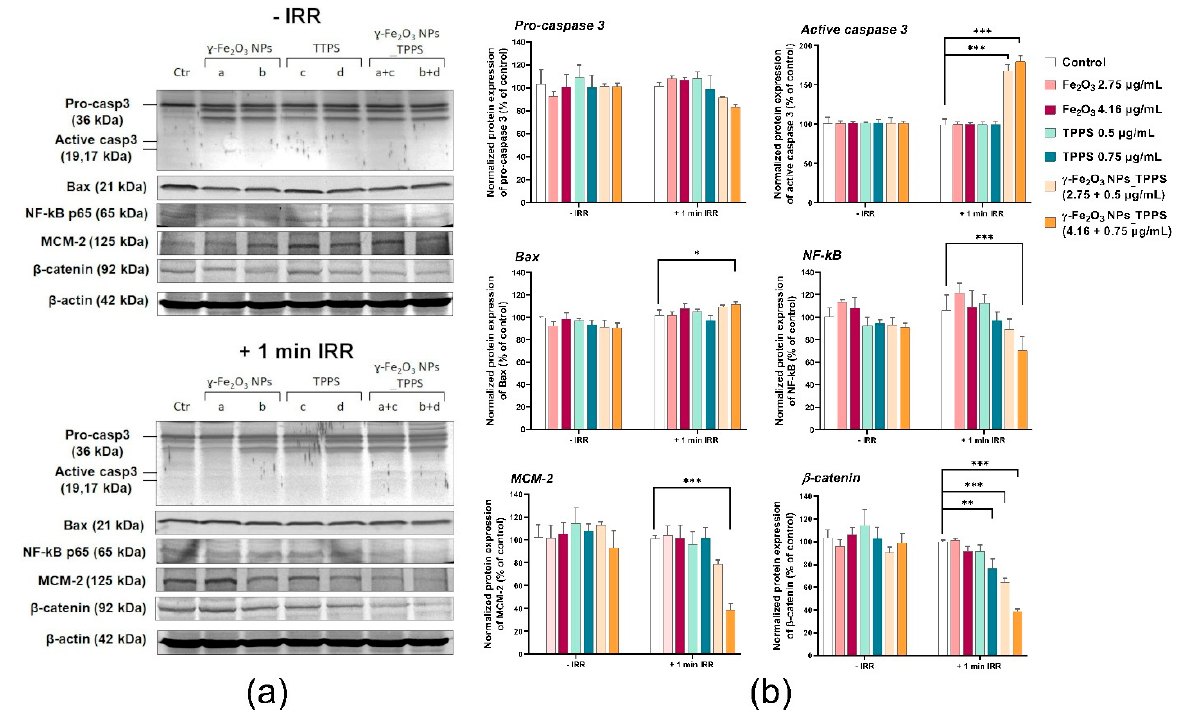
Figure 15. The protein expression of Pro-caspase 3, caspase 3, Bax, NF-kB, MCM-2 and β -catenin in Mel-Juso cells after 24 h incubation with 2 different concentrations of γ -Fe 2 O 3 NPs, TPPS and their mixture and exposure to no irradiation vs. 1 min irradiation ( λ ~ 405 nm, 1 mW/cm 2 ) conditions. ( a ) Blot bands corresponding to control (Ctr), γ -Fe 2 O 3 NPs (a. 2.75; b. 4.16 µ g/mL), TPPS (c. 0.5; d. 0.75 µ g/mL) and γ -Fe 2 O 3 NPs_TPPS complex (a+c, b+d); ( b ) Quantification of blot images. Data ( n = 3) were normalized to β -actin and expressed as percentages related to control (100%) ± standard deviation (SD). The results were considered statistically significant when * p < 0.05; ** p < 0.01; *** p < 0.001 (sample vs. control).